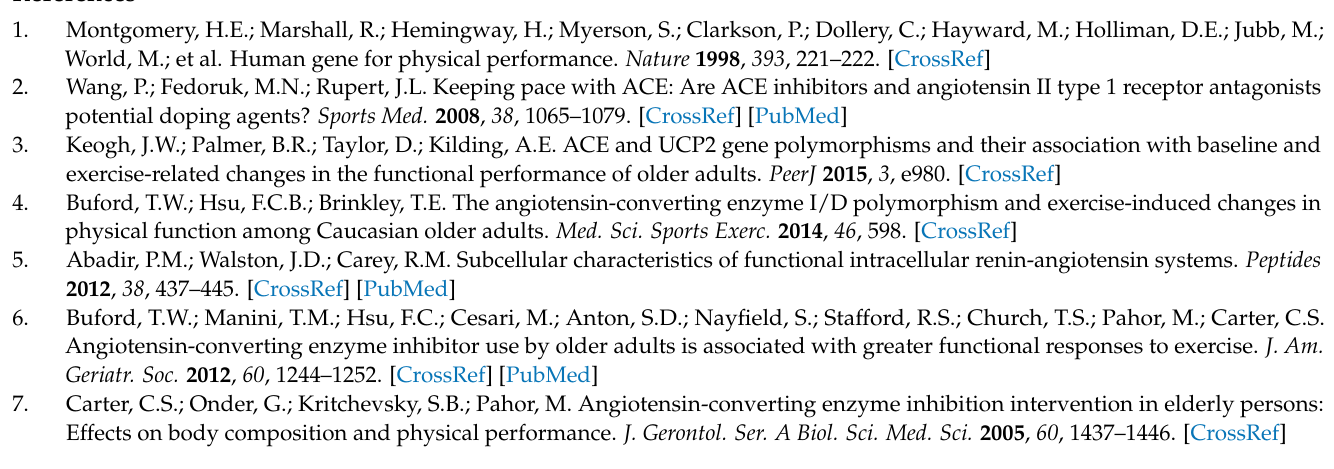
Figure S6: Genetic networks for climbing speed and endurance combined; Figure S7: Genetic networks of human orthologs for physical performance; Figure S8: Genetic networks for sensitivity to Lisinopril treatment at young age; Figure S9: Lisinopril treatment effect on endurance in RNAi genotypes; Figure S10: Verification of in vivo RNAi knockdown using qRT-PCR; Table S1: qRT-PCR of in vivo RNAi-axn, RNAi- fz, RNAi-nemo, RNAi-wingless; Table S2: Sensitivity of 126 DRGP lines to Lisinopril treatment results; Table S3: Physical performance results and means of 126 DGRP lines submitted to DGRP pipeline; Table S4: GWA results for physical performance; Table S5. Candidate gene information; Table S6: GWA results for sensitivity to Lisinopril; Table S7: Physical performance of in vivo RNAi